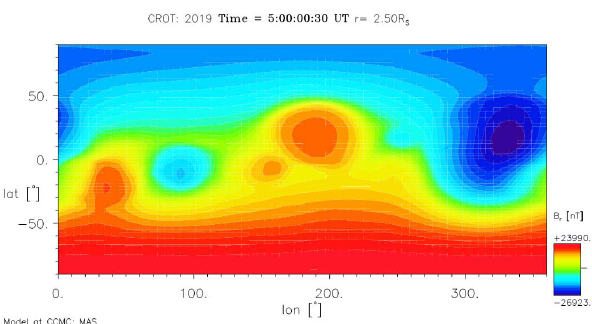
Fig. 2. Example of an extrapolated magnetic field at the source sur- face. From CCMC,